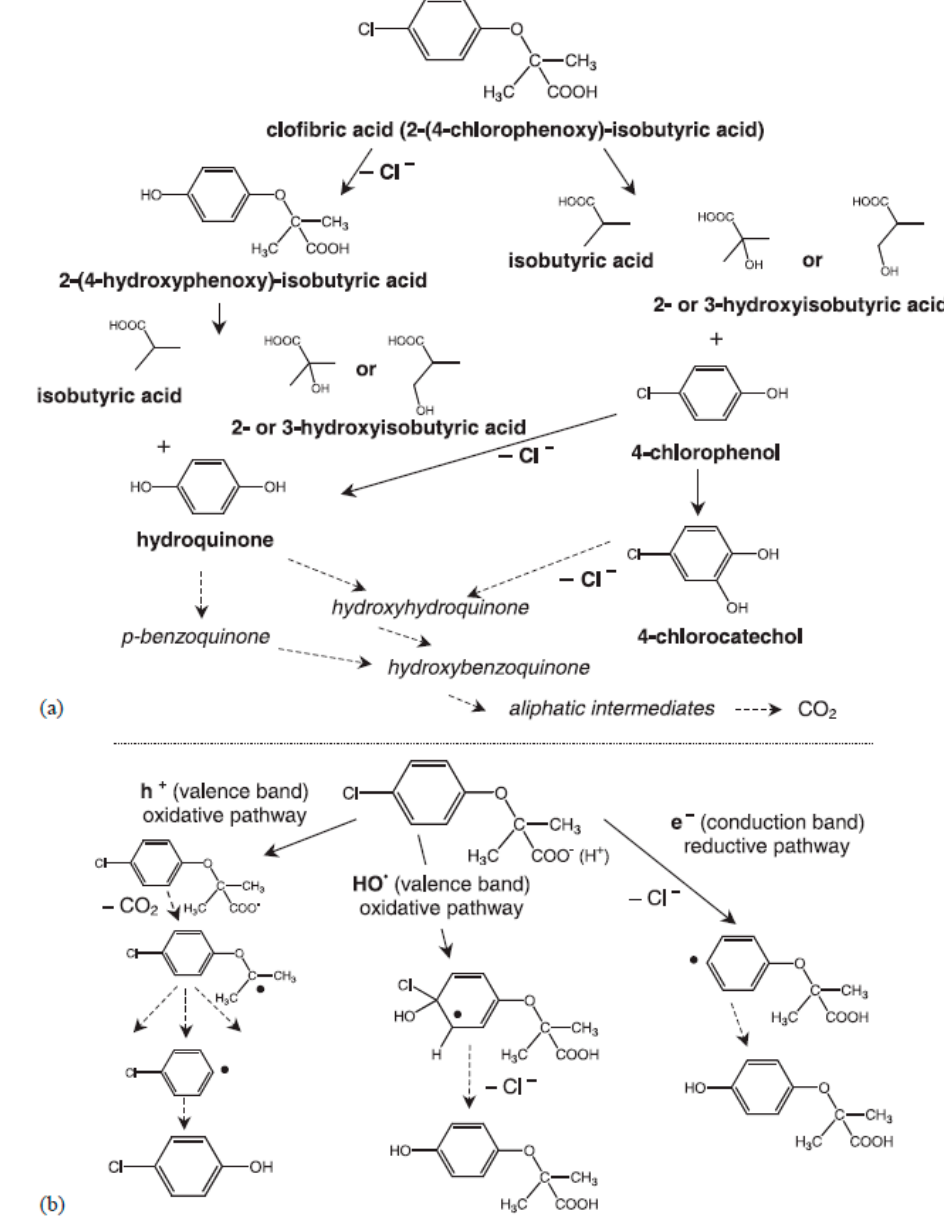
Figure 6. ( a ): Suggested simplified degradation scheme of the photocatalytic degradation of clofibric acid (Bold: identified intermediates) and ( b ) example for possible oxidative and reductive reaction pathways of clofibri cacid. Reproduced with permission from [44], Copyright Elsevier Ltd., 2003.